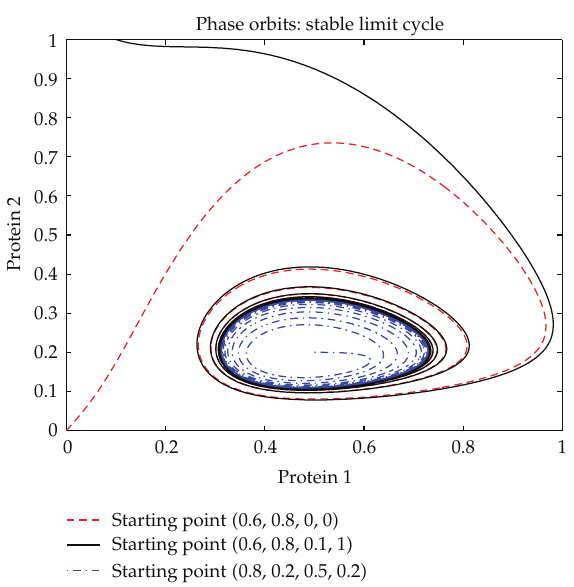
Figure 1: E ffi ciency